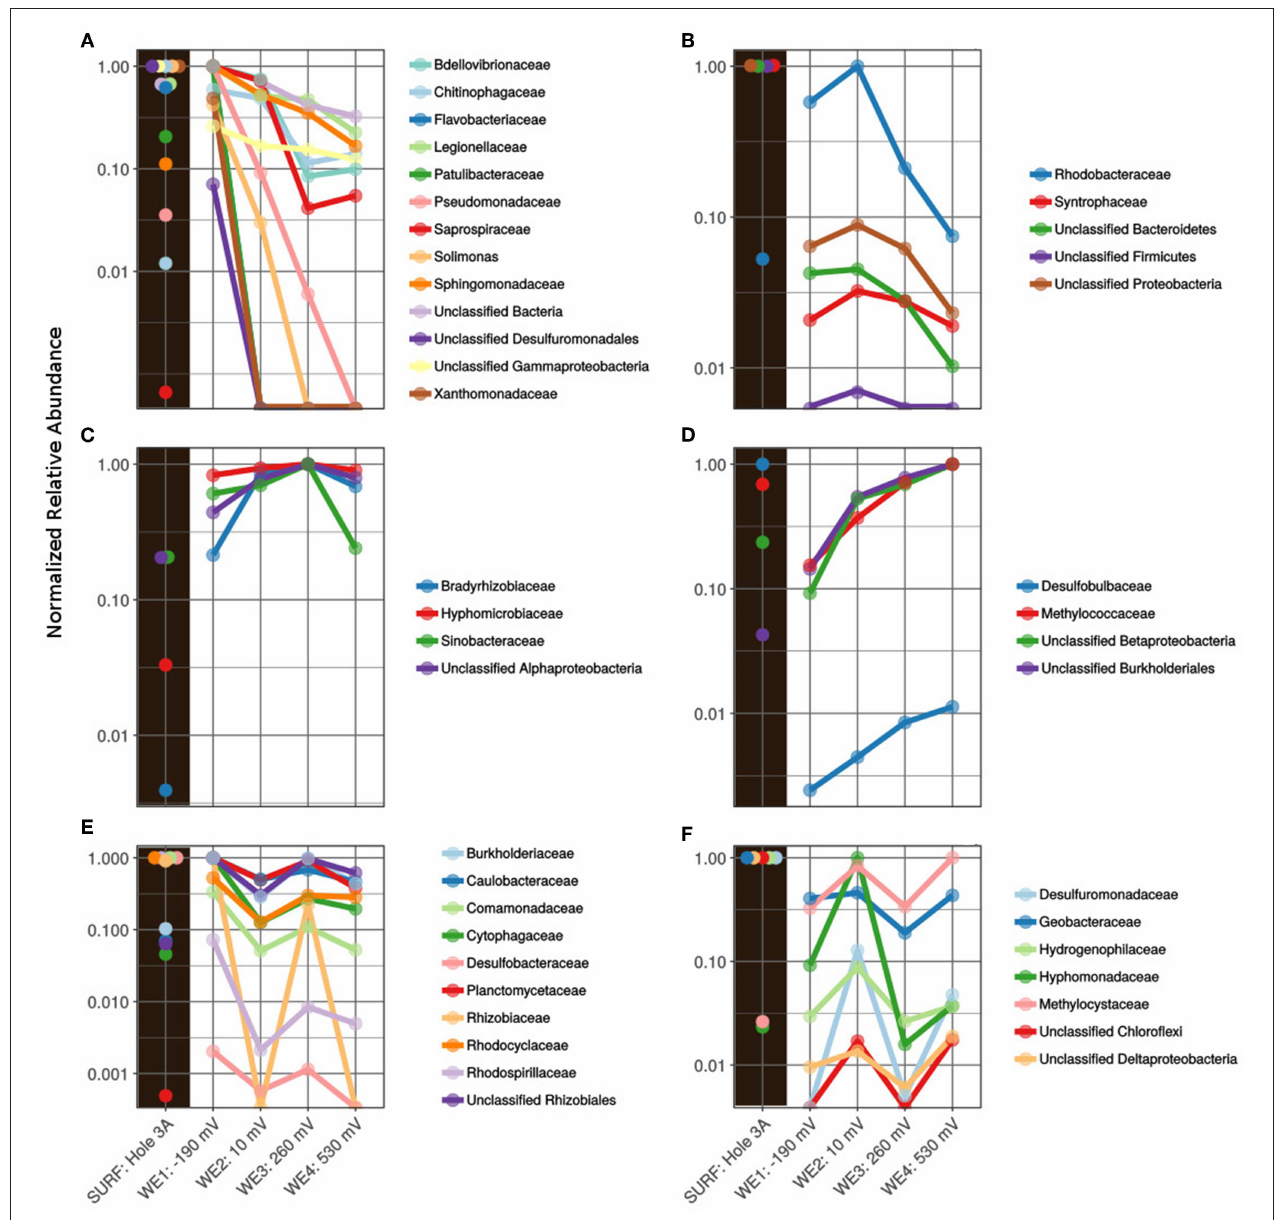
FIGURE 3 | Active family-level normalized relative abundance of bacterial community present in the in situ electrochemical colonization (ISEC) reactor sorted by poised electrodes: (A) maximum at WE1: − 0.19 V vs. SHE, (B) maximum at WE2: + 0.01V vs. SHE, (C) maximum at WE3: + 0.26V vs. SHE, (D) maximum at WE4: + 0.53V vs. SHE, (E) maximum at WE1 and WE3, and (F) maximum at WE2 and WE4, with reference to the inoculum-fluid of SURF DUSEL 3A (labeled as SURF: Hole